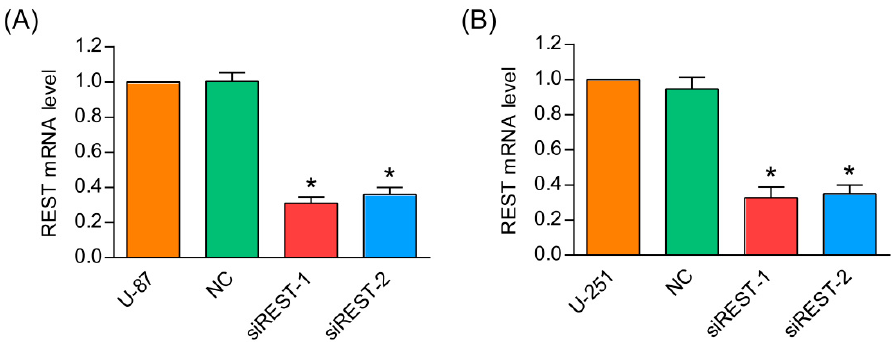
Figure 1. Cont. Figure 1.